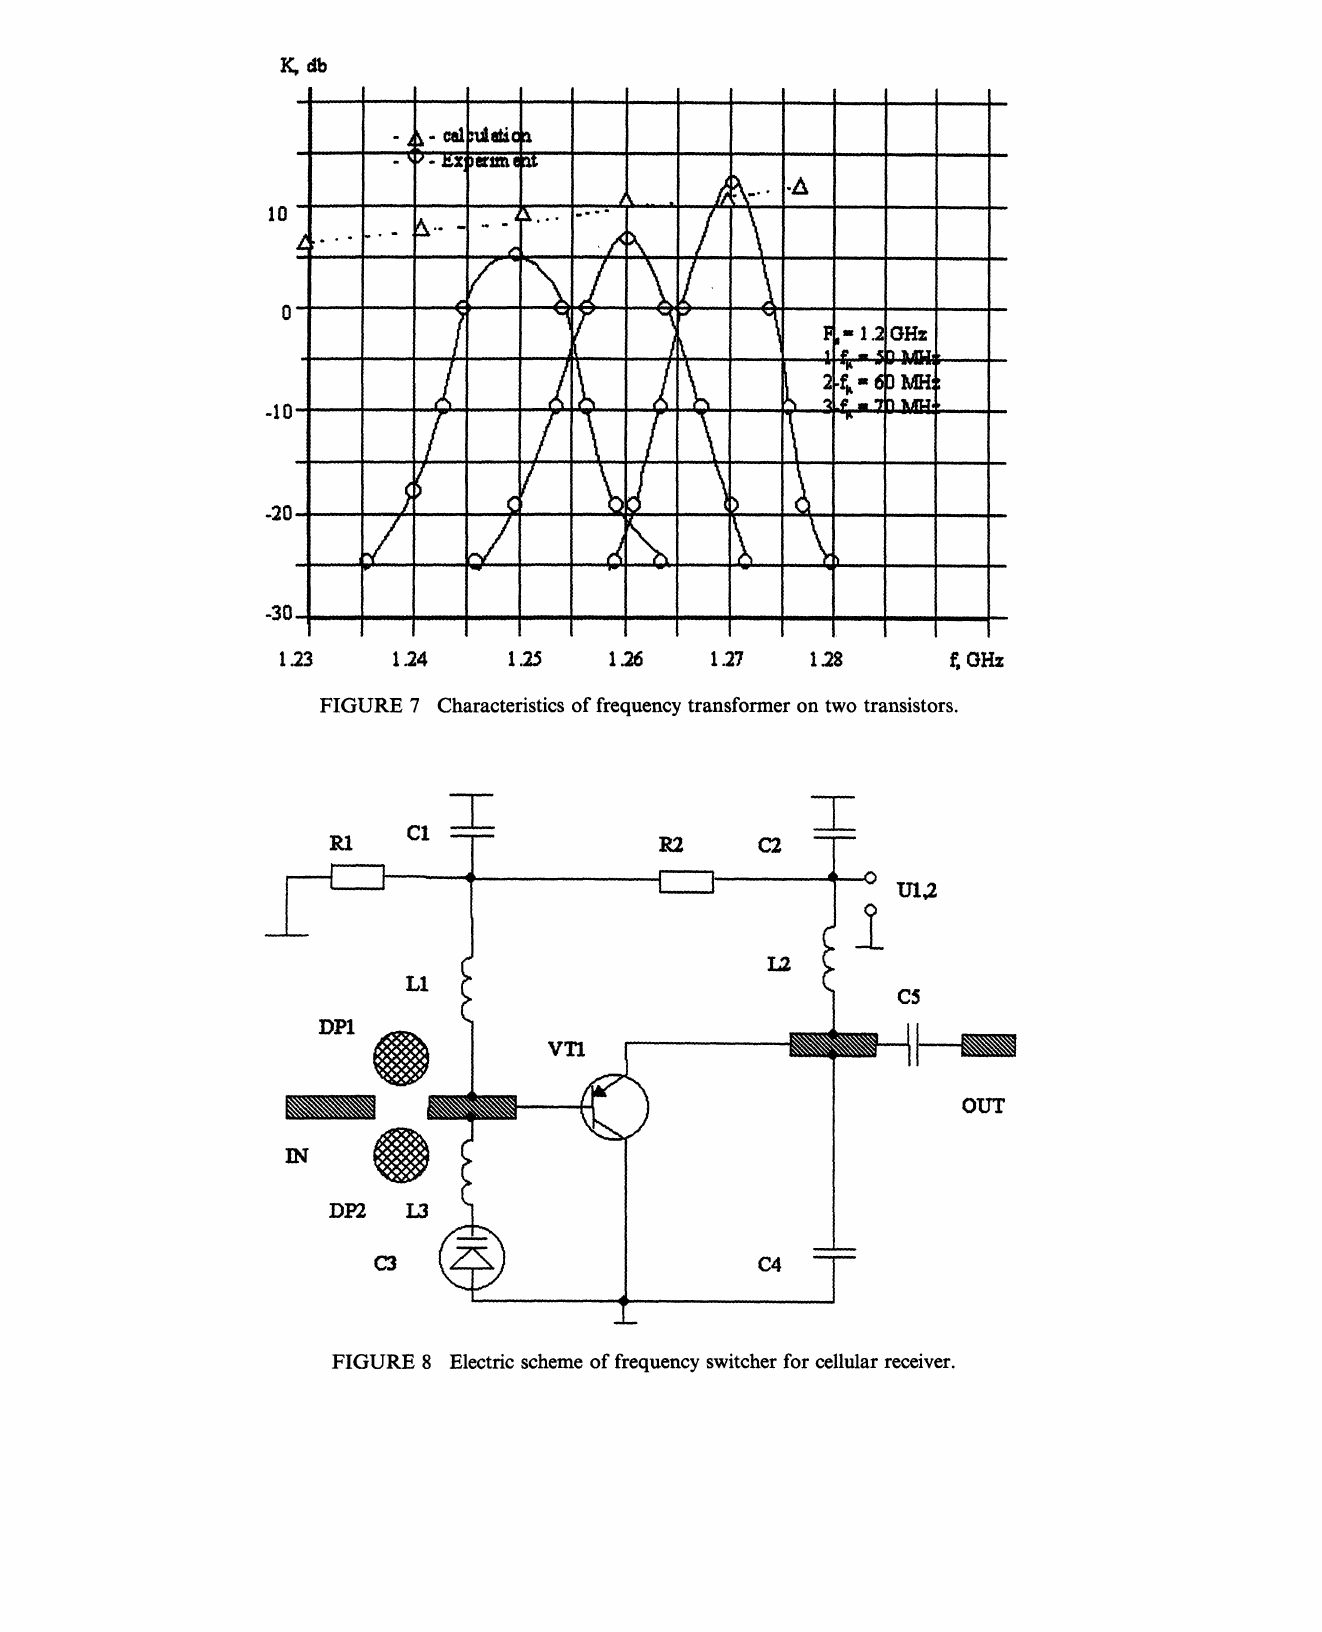
FIGURE 8 Electric scheme of frequency switcher for cellular